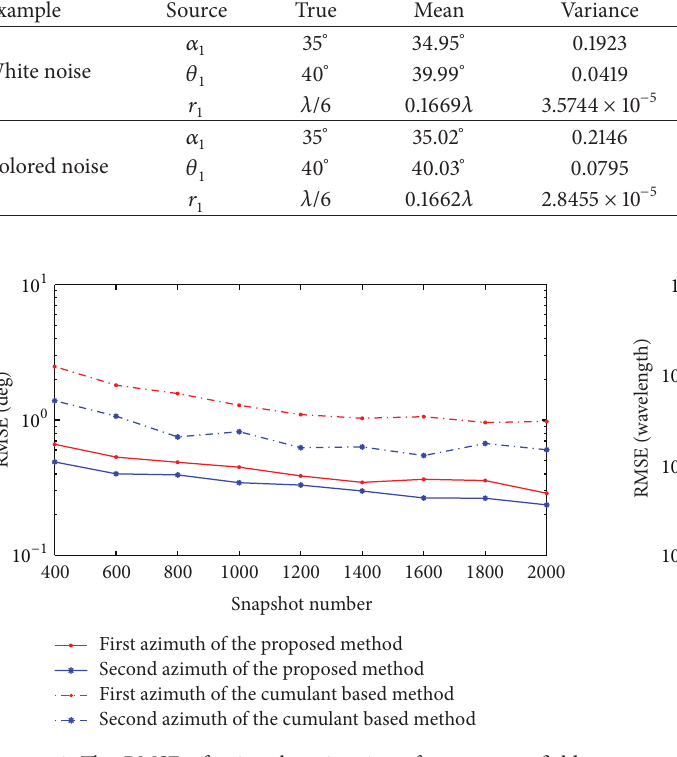
Figure 7: The RMSE of range estimations for two near-field sources using the proposed method and the cumulant based method versus snapshot